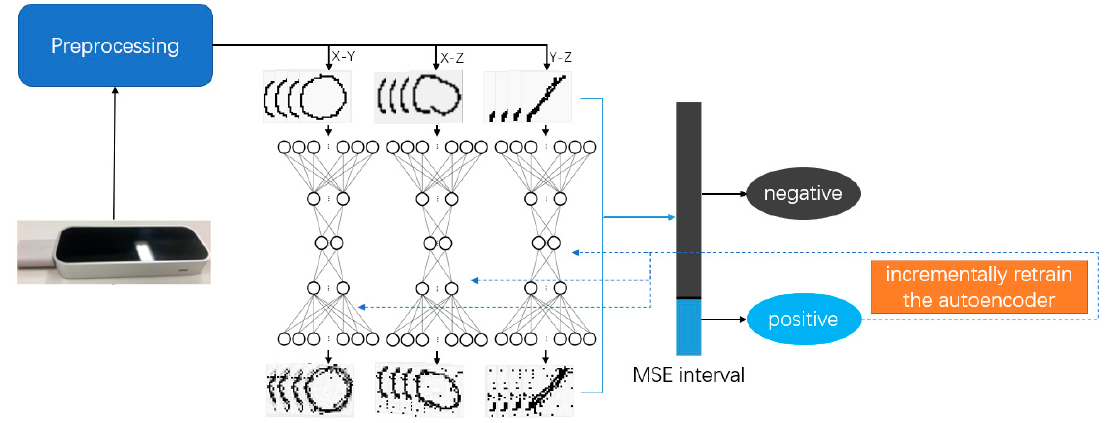
Figure 4. Algorithm flow chart.